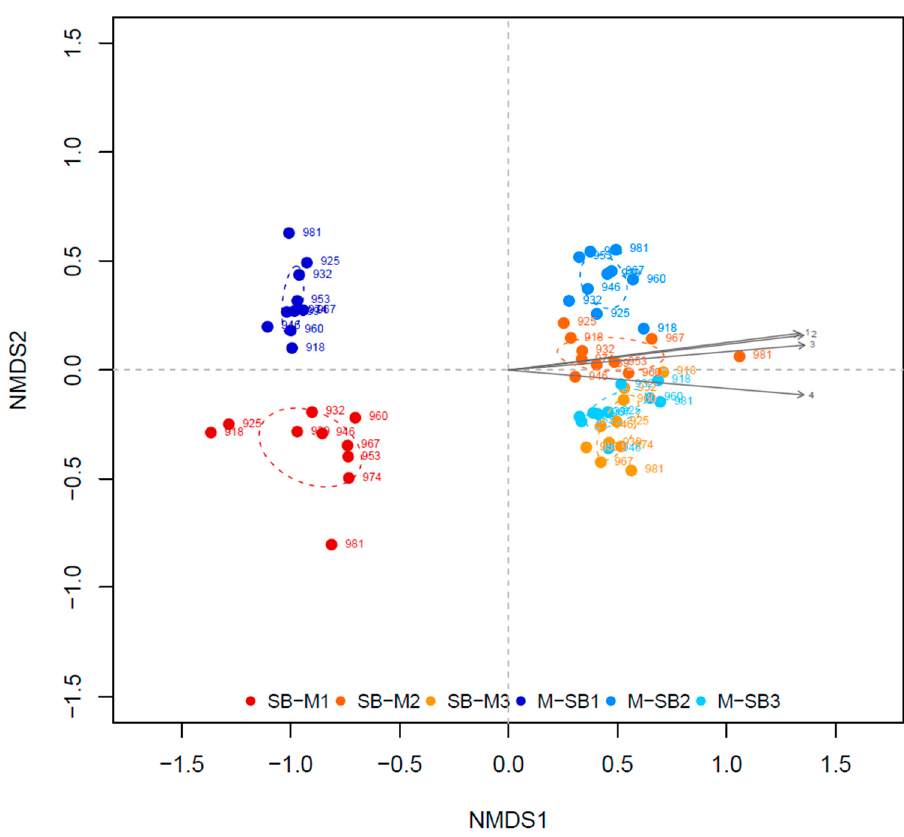
Figure 3. Non-metric dimensional scaling (NMDS) of all six reactors (stress = 0.14). The environmental vectors symbolize 1) total Kjeldahl nitrogen (TKN), 2) total ammonium nitrogen (TAN), 3) ammonia nitrogen (NH 3 ), as well as 4) pH value, p = 0.001, R 2 >